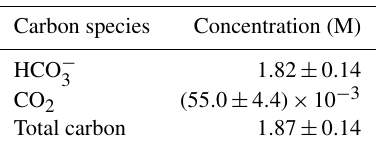
Table 1. Concentrations of carbon species in CO 2 -saturated elec- trolyte at 10 ◦ C and 1013hPa CO 2